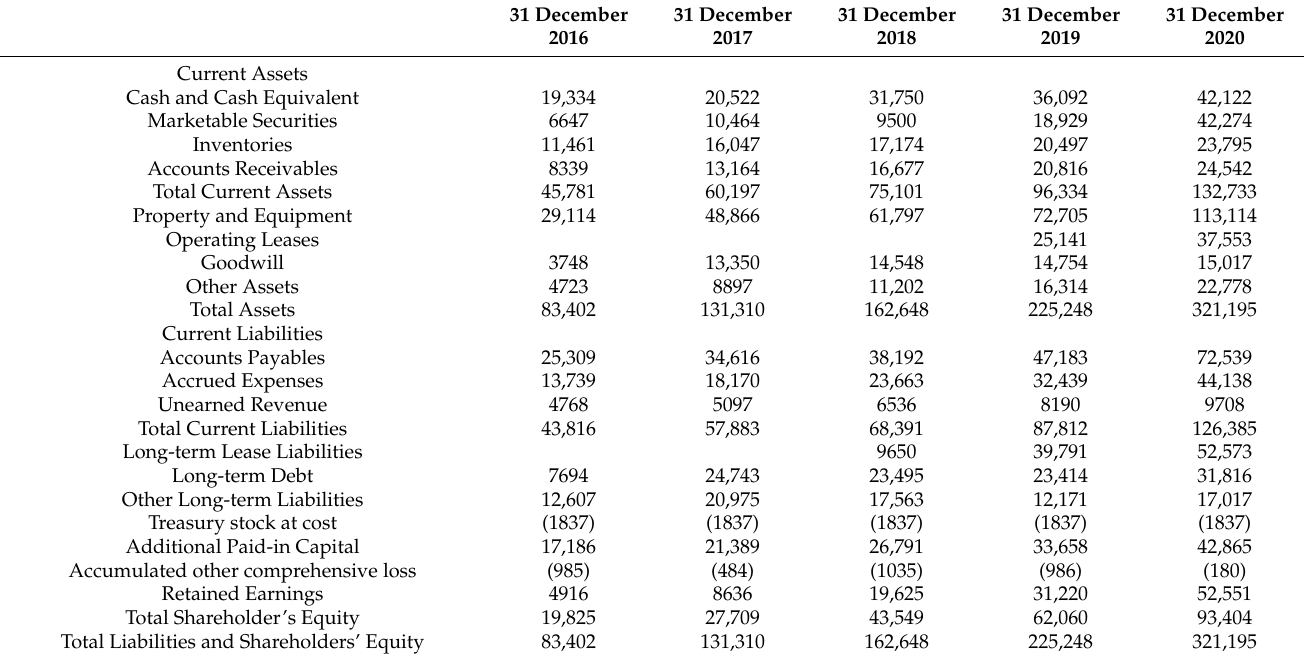
Table 1. Amazon’s annual statement of financial position from